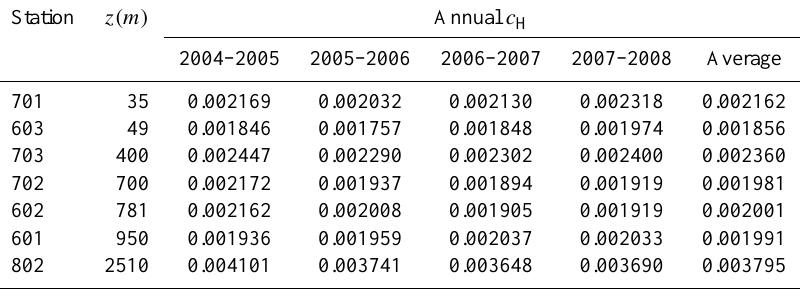
Table 4. Adjusted c H values for each hydrological year (1 September to 31 August) at stations 601, 602, 603, 701, 702, 703 and 802.